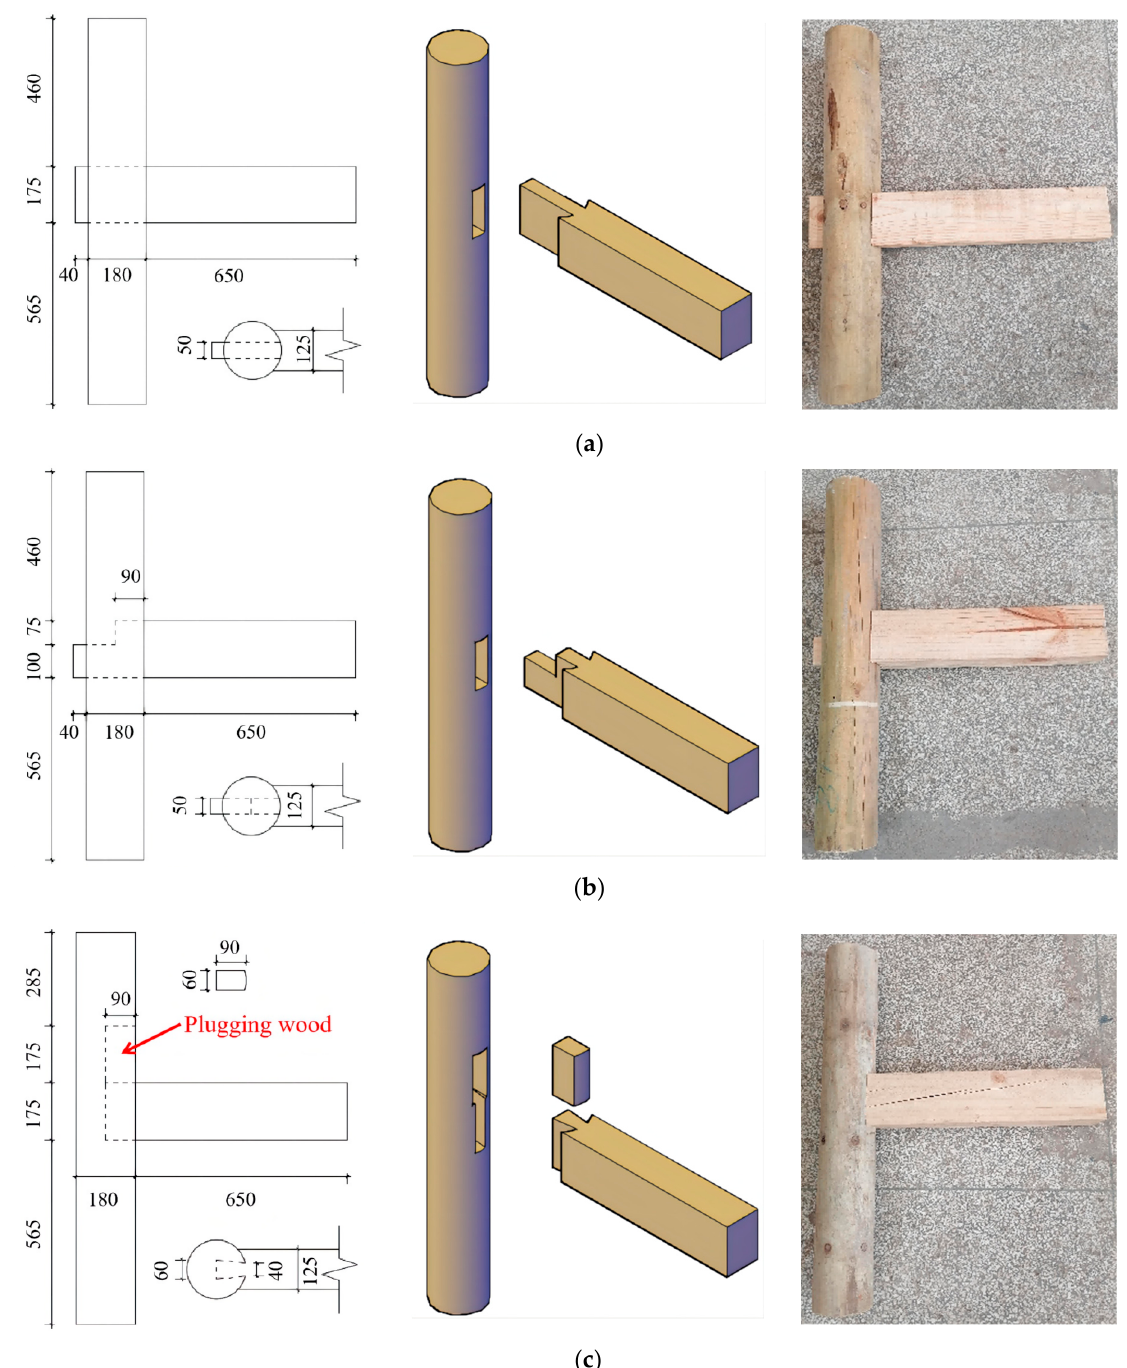
Figure 2. Detailed dimensions of tenon and mortise joints sample (unit: mm): ( a ) Straight tenon; ( b ) Penetrated tenon; ( c ) Dovetail tenon.